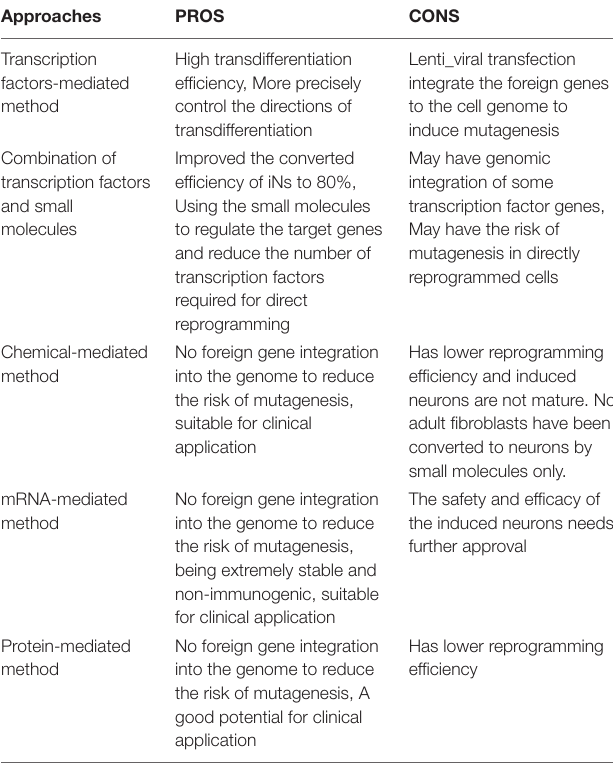
TABLE 2 | Comparison of the PROS and CONS of different reprogramming